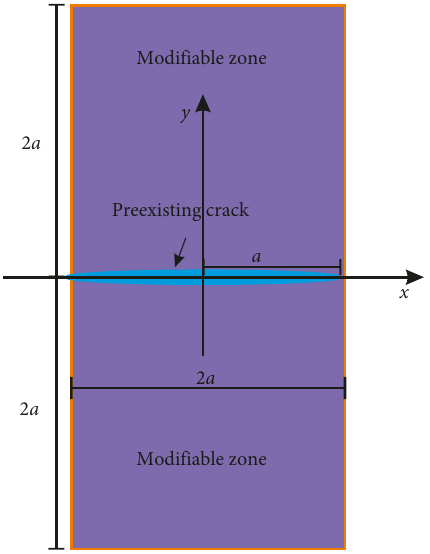
Figure 11: Schematic diagram of the scope of the stress modifiable zone.